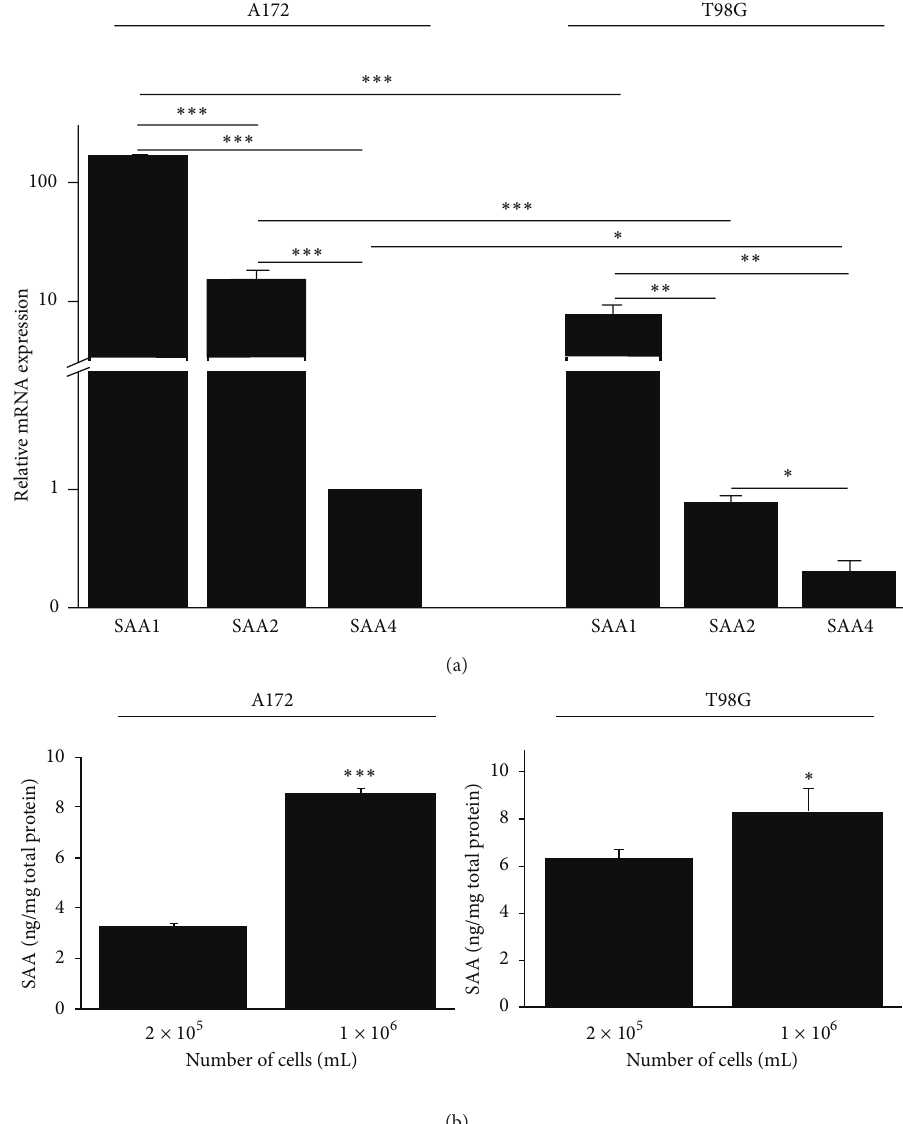
Figure 6: SAA is expressed and produced in A172 and T98G cells. (a) Quantitative real-time PCR was performed to assess the mRNA expression of SAA isoforms SAA1, SAA2, and SAA4, in A172 and T98G cells. (b) The production of SAA protein was measured in two cell densities by ELISA. Data represent the mean ± SEM of three experiments. ∗ 𝑃 < 0.05, ∗∗ 𝑃 < 0.01 , and ∗∗∗ 𝑃 < 0.001